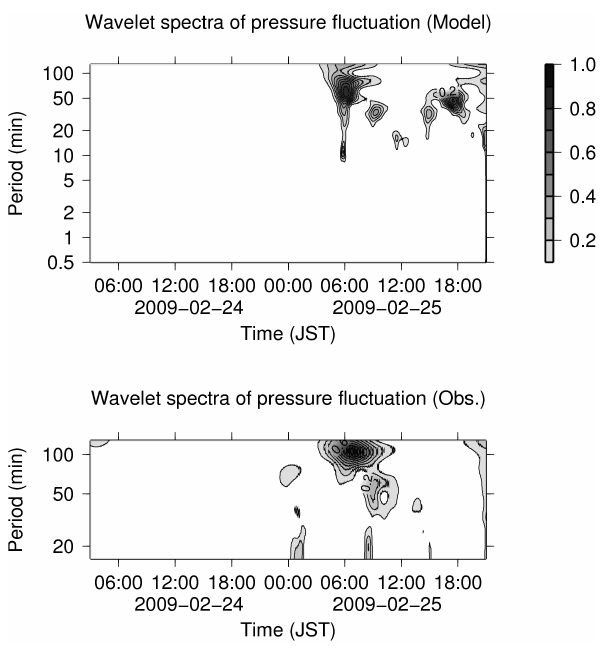
Fig. 16. Continuous wavelet spectra of the pressure disturbance, normalized to the maximum spectrum